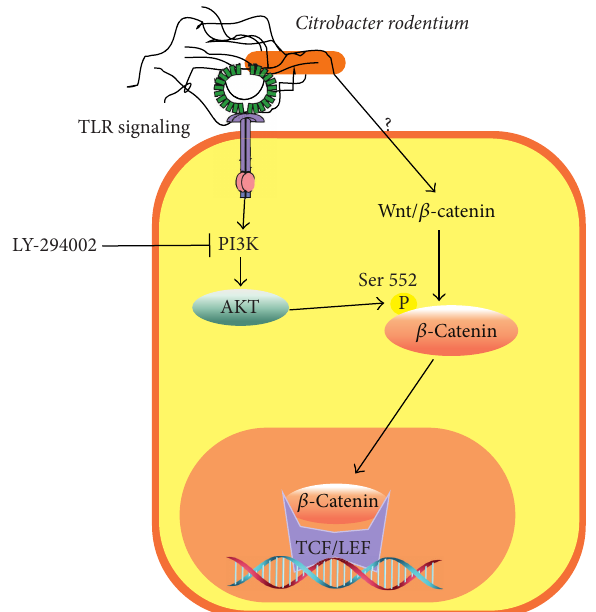
Figure 3: The PI3K/Akt signaling pathway enhances 𝛽 -catenin activation. In colon epithelial cells infected with Citrobacter roden- tium , Akt phosphorylates 𝛽 -catenin at Ser552. The activation of 𝛽 - cateninincreasesc-mycandreducesTNF 𝛼 andIFN 𝛾 expression.An opposite effect is observed in cells incubated with the PI3K inhibitor